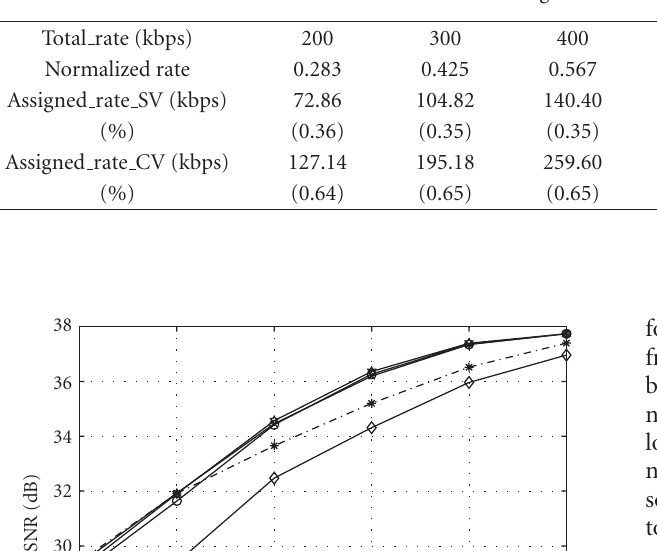
Table 5: Assignment of forwarding date rate.